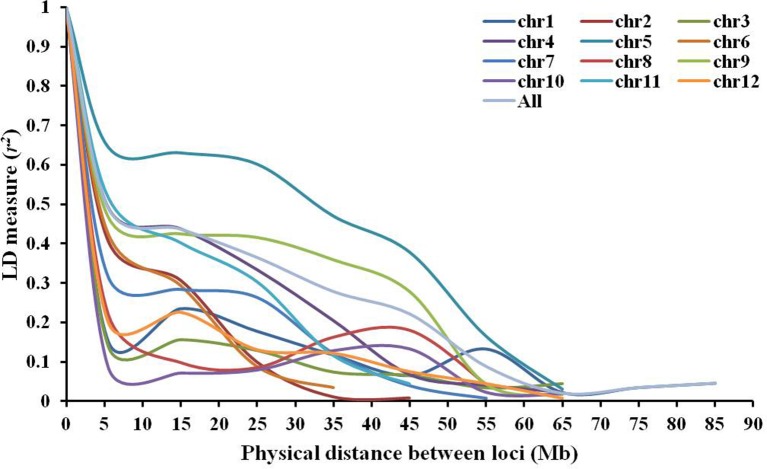
Linkage disequilibrium decay across all 12 chromosomes within the association mapping panel of 164 Solanum lycopersicum accessions revealed by plots of linkage disequilibrium (LD) values (r2) against physical genetic distance (Mb) between pairs of InDel markers.